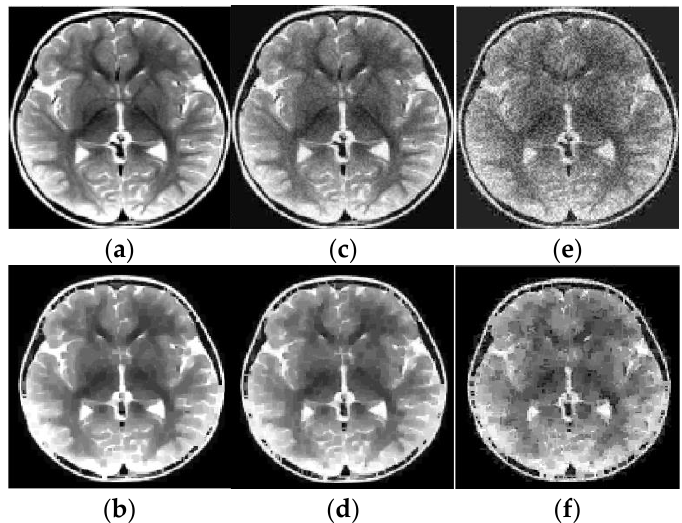
Figure 10. Results of reconstruction of MRI human brain image based on qualitative data. ( a ) Original image; ( b ) Reconstructed image; ( c ) Original low noise image; ( d ) Reconstructed low noise image; ( e ) Original noisy image; ( f ) Reconstructed noisy image.